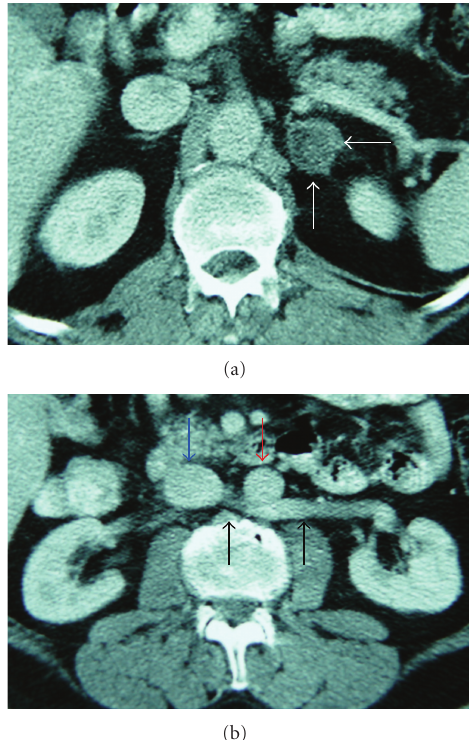
Figure 2: Axial contrast-enhanced computed tomography (CT) images revealed hypodense mass measuring 3 . 5 × 3 cm within the left adrenal gland (white arrows). The density of the mass was +14 HU after 65 seconds following contrast administration (a). RLRV (black arrows) passing posteriorly to the abdominal aorta (red arrow), joining inferior vena cava (blue arrow), was also depicted